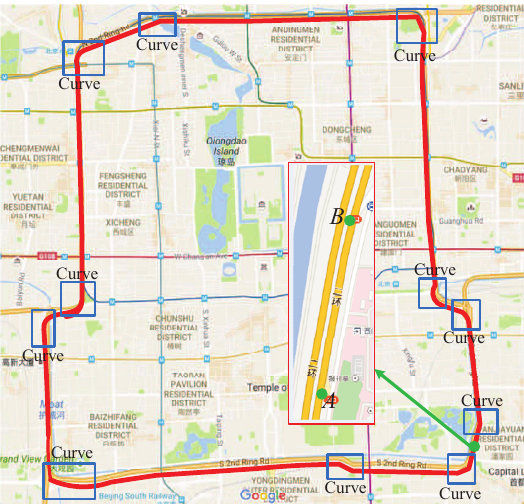
Figure 2. The outer ring of Beijing’s second ring freeway (from Google Maps). The points A and B are marked as the first on-ramp and the first off-ramp, respectively. The segment between A and B is labeled as cell 1 (Note: the Chinese words in this map are just the name of some buildings and will not affect the meaning of this